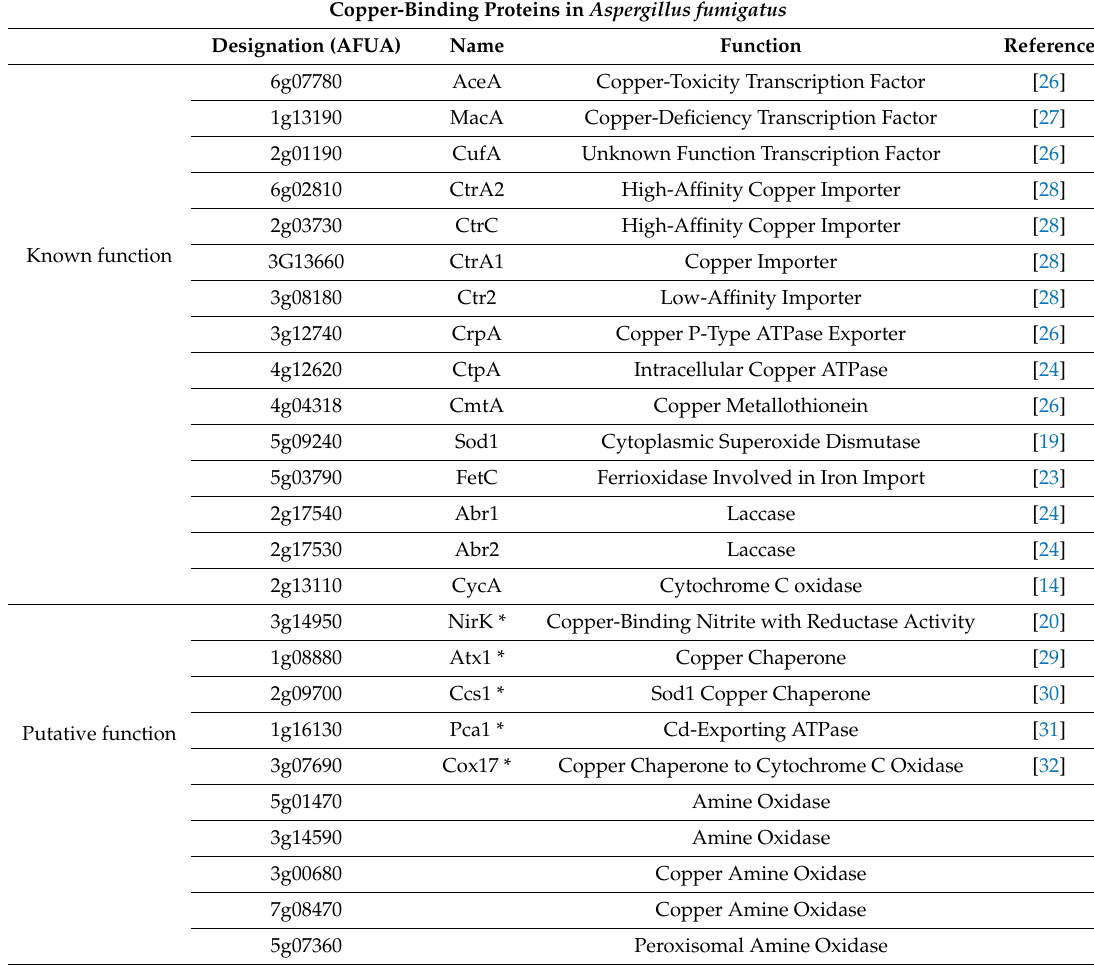
Table 1. Proteins that bind copper or have predicted copper-binding sites. Proteins that contain ‘*’ are named after homologous genes that have been characterized in other